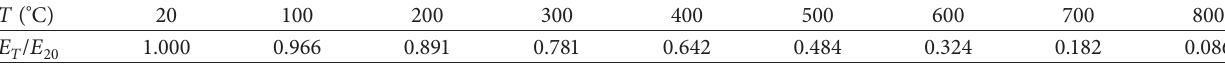
Table 8: Recommendation retention factors for the elastic